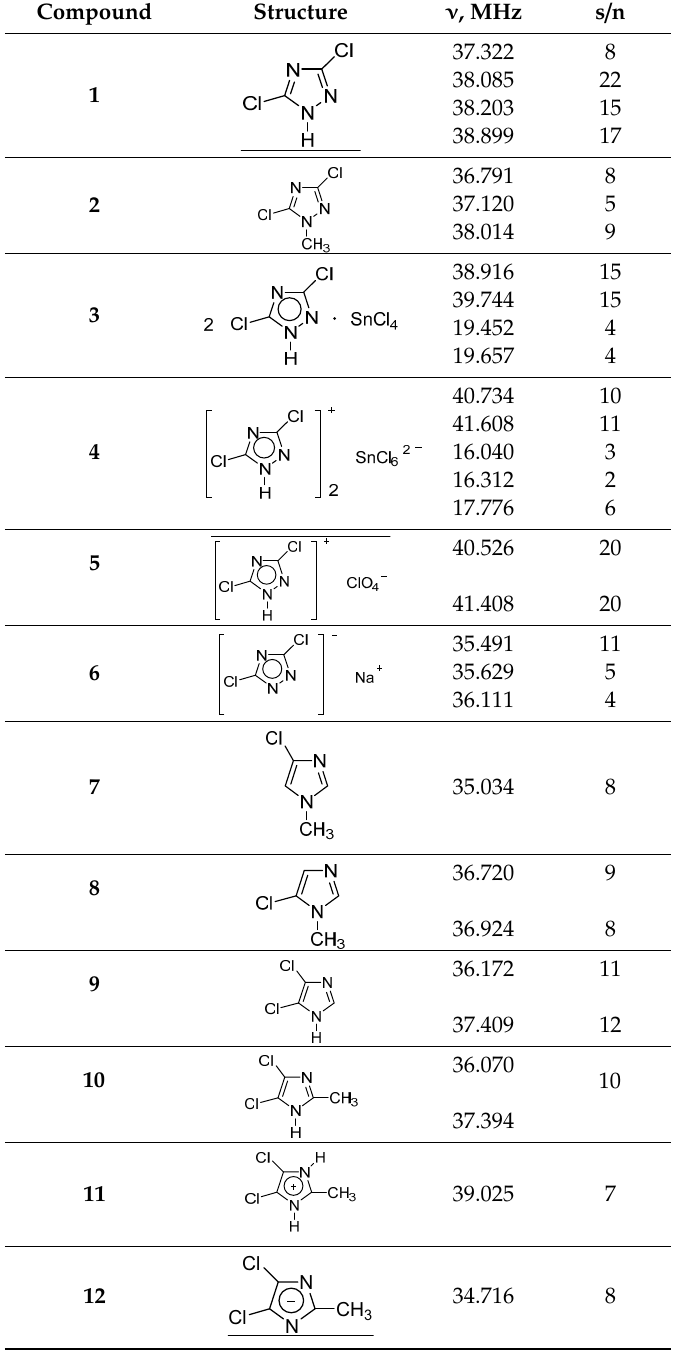
Table 1. The 35 Cl NQR frequencies at 77 K ( ν , MHz) and signal-to noise ratio (s / n) in the spectra of chloro-containing 1,2,4-triazoles ( 1 – 6 ) and imidazoles ( 7 – 12 ).